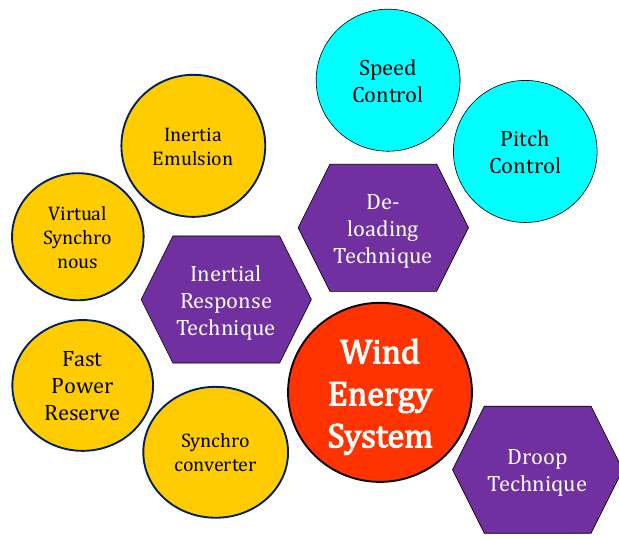
Figure 8. Several approaches of frequency control by wind